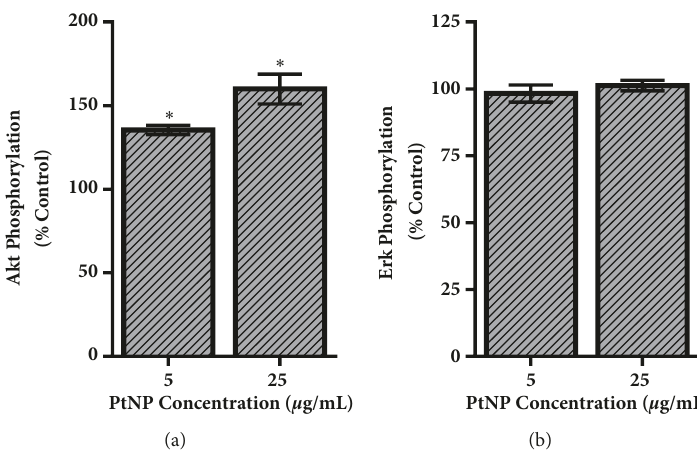
Figure 5: Evaluation of IGF-1 dependent signal transduction. HepG2 cells were exposed to PtNPs and then stimulated with IGF-1 to induce the PI3K/Akt and Ras/Erk signaling pathways. Activation of these cascades was assessed via normalized phosphorylation levels of (a) Akt and (b) Erk, respectively. Data represents 3 independent trials with ∗ denoting statistical significance from untreated controls ( p < 0.05).